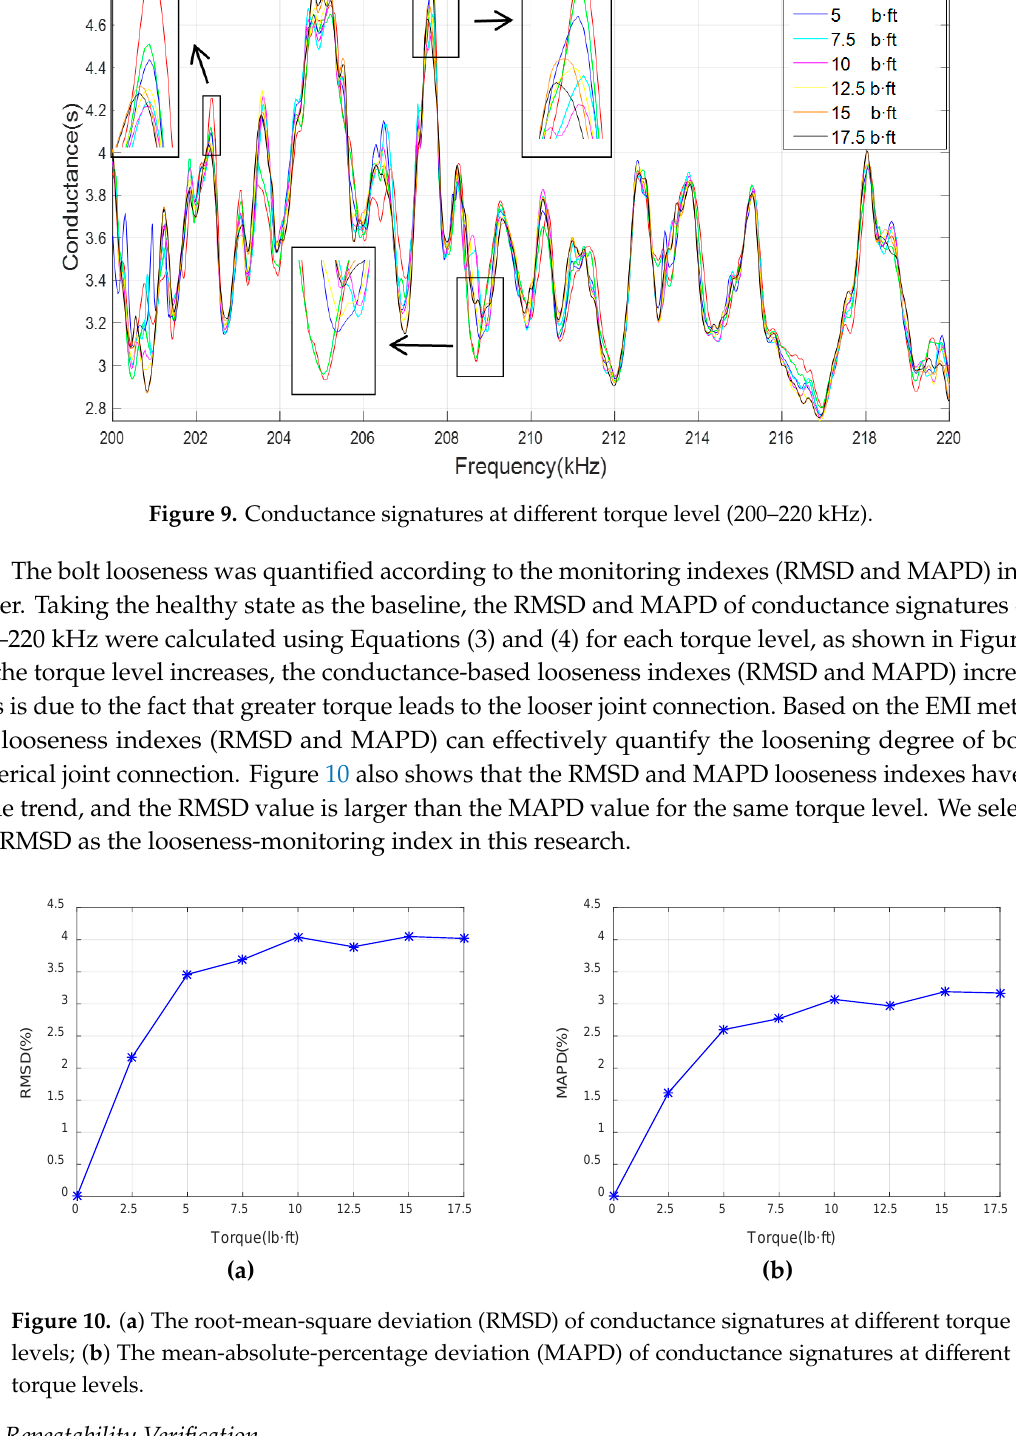
Figure 10. ( a ) The root-mean-square deviation (RMSD) of conductance signatures at different torque levels; ( b ) The mean-absolute-percentage deviation (MAPD) of conductance signatures at different torque levels.